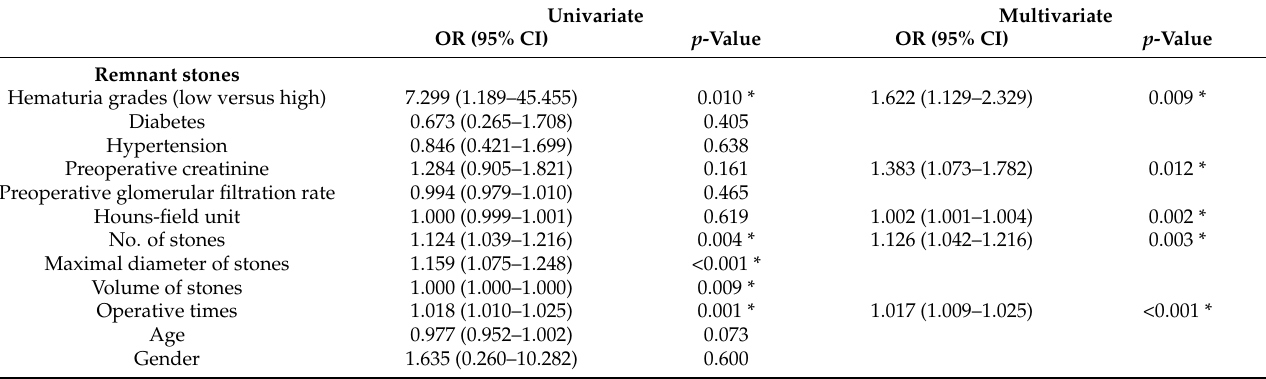
Table 5. Logistic regression analysis for prediction of remnant stones and the occurrence of acute pyelonephritis or sepsis in the development group of